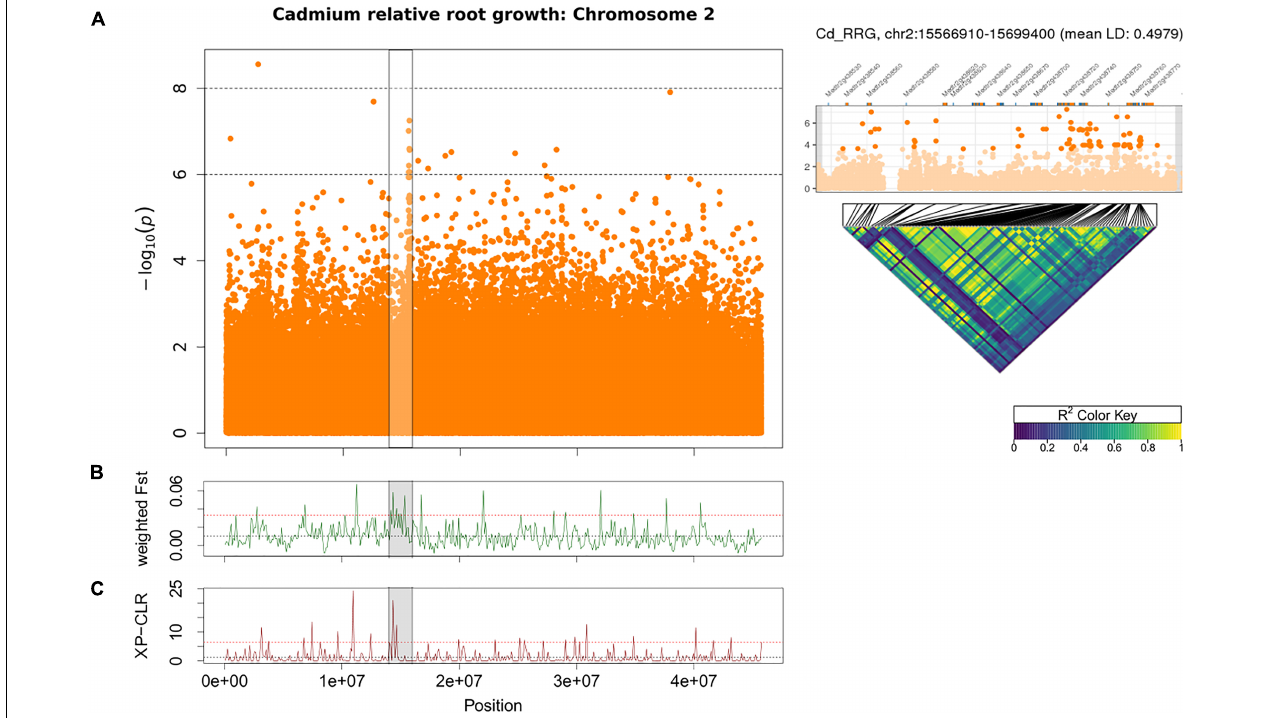
FIGURE 4 | Manhattan plot of Cd relative root growth (RRG) associations on chromosome 2 using GAPIT (A) . The highlighted cluster of SNP’s (horizontal black bars) contains multiple ankyrin repeat genes (see Table 2 ). Each point represents a SNP, the x -axis signifies the position on the chromosome while the y -axis is the –log 10 of the p -value. Pairwise linkage disequilibrium (LD) among the 100 most significant SNPs in the peak is shown as a heatmap on the right, the most significant SNPs and Mt4.0 genes in this region shown above the heatmap. The black lines mark the position of each SNP in the peak, dark blue color signifies no LD, green to yellow is high to maximum LD. Weighted F st statistics from sliding window analysis (100 kb windows) on chromosome 2 with GWAS peak marked in gray (B) . Higher F st indicates genomic differentiation based on the groups of plant genotypes with the highest vs. lowest Cd RRG-values. XP-CLR is a two-group comparison of selective sweeps using plant genotypes with the highest vs. lowest Cd RRG-values (C) . The dashed black line represents the mean F st or CLR-values for the chromosome, the dashed red line represents windows ≥ 5% of the highest F st or CLR-values for the chromosome.